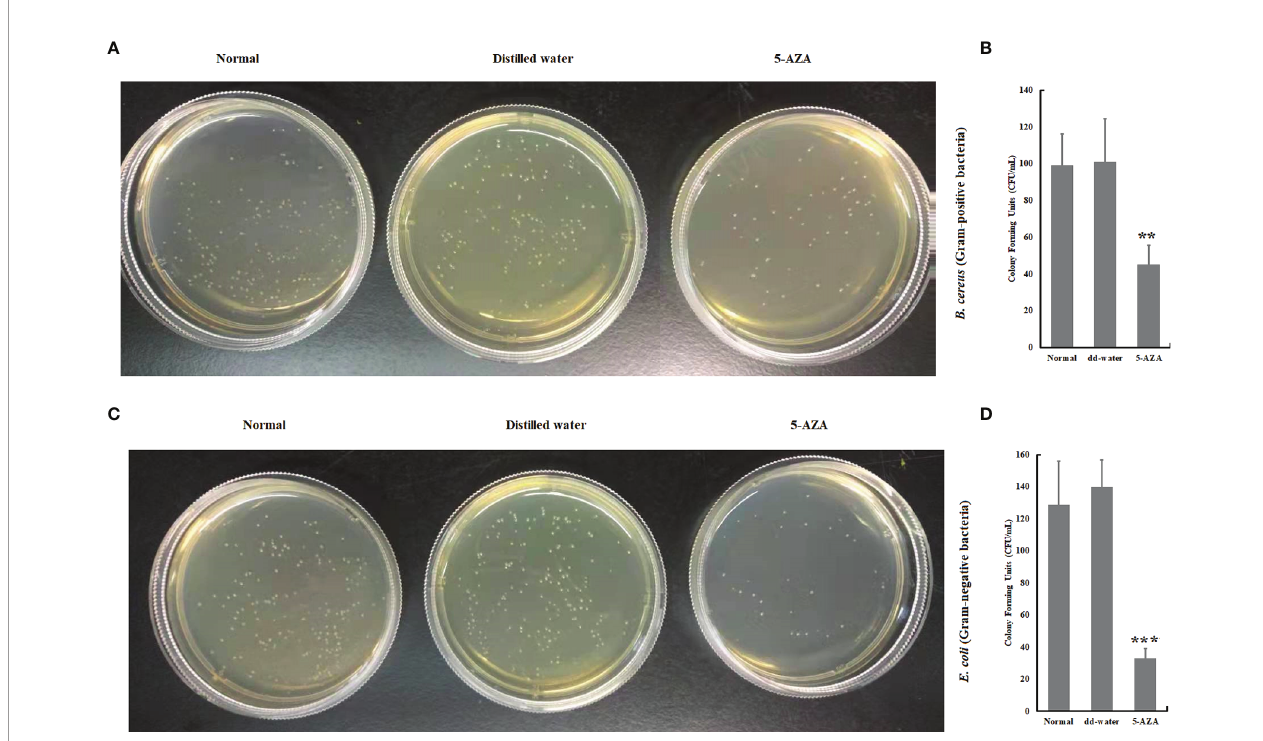
FIGURE 9 | The plasma anti-bacterial activity was increased in the 5-AZA, and gram-positive bacteria (A, B) or 5-AZA and gram-negative bacteria (C, D) treated larval hemolymph. Plasma was sampled from A. pernyi treated with 5-AZA (n = 3) and distilled water. Equal volumes (10 m l) of plasma and bacterial suspension were incubated at 25°C for 1 h. Asterisks indicate signi fi cant differences (** p < 0.01, *** p <